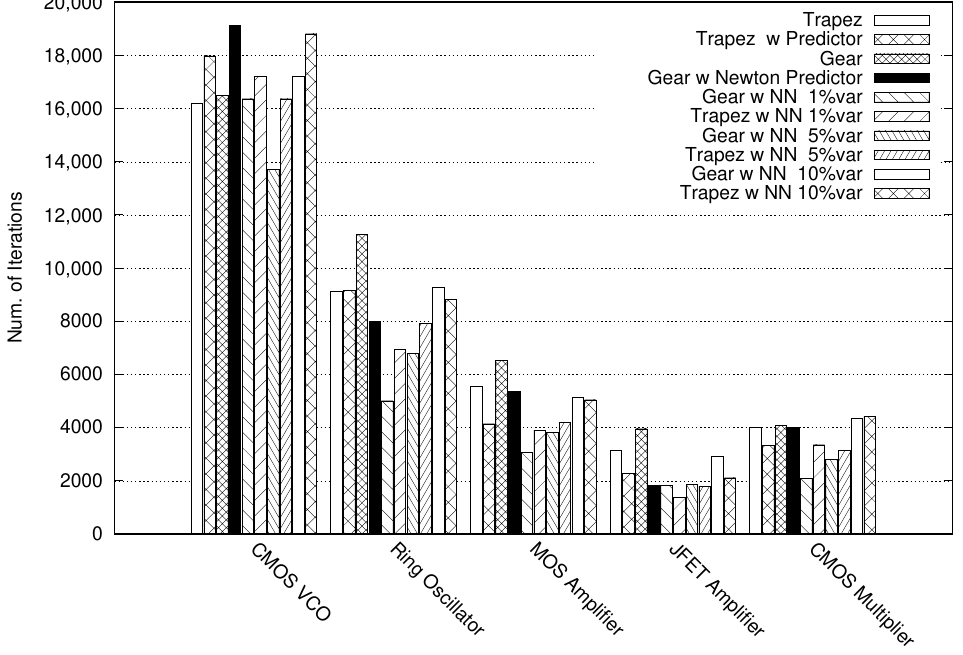
Figure 3. Number of Iterations Required to Compute a Given Circuit for Different Types of Integration Methods and Variation of Component Parameters.